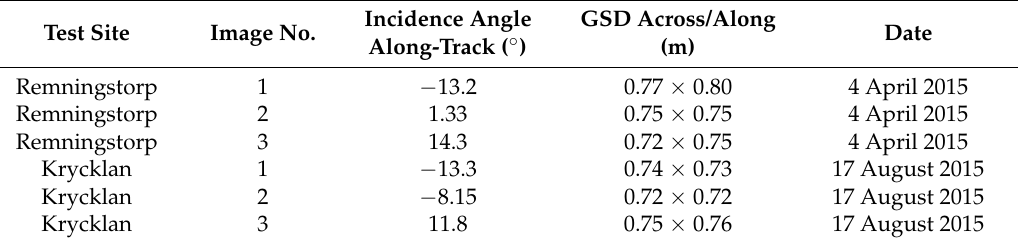
Table 2. Acquisition properties for the satellite images. Ground sampling distance (GSD).